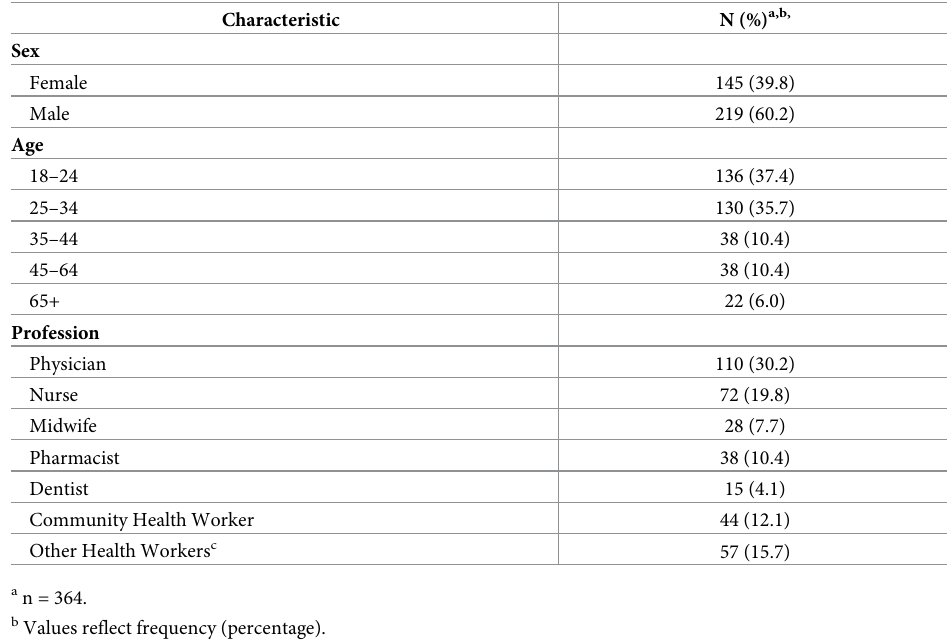
Table 1. Respondent